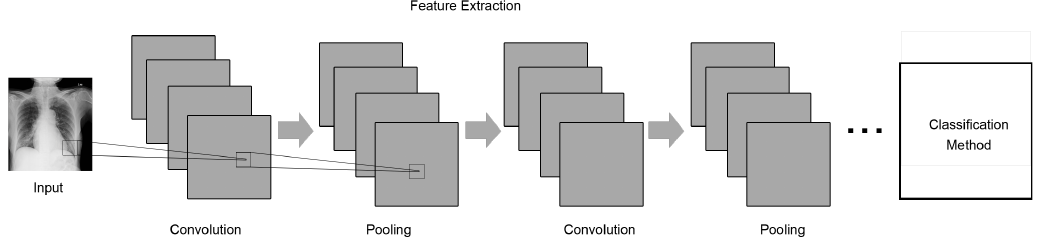
Figure 1. Generic model architecture with convolutional layers. Source: prepared by the authors and inspired by [42].